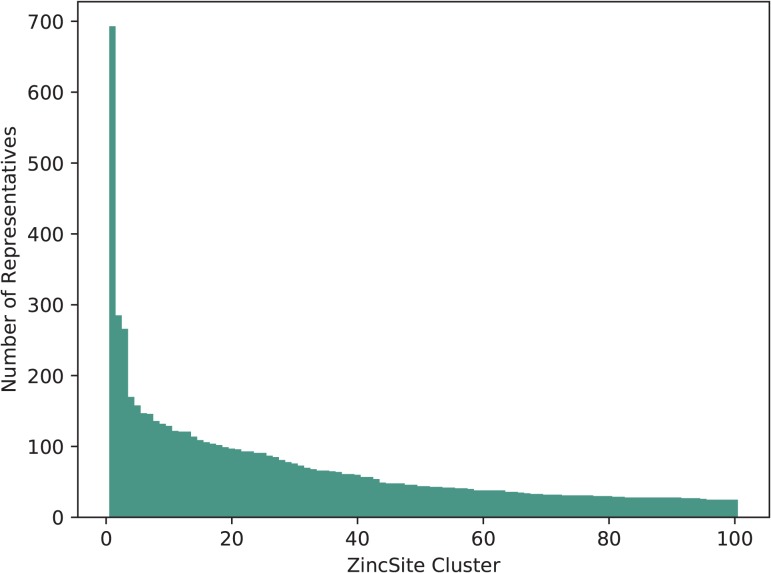
The number of representatives in the largest 100 binding site clusters, ranked on the \documentclass[12pt]{minimal}
\usepackage{amsmath}
\usepackage{wasysym}
\usepackage{amsfonts}
\usepackage{amssymb}
\usepackage{amsbsy}
\usepackage{upgreek}
\usepackage{mathrsfs}
\setlength{\oddsidemargin}{-69pt}
\begin{document}
}{}$x$\end{document}-axis by the number of sites in that cluster. Carbonic anhydrase, ranked first, can be seen as a clear outlier—it is very highly represented.